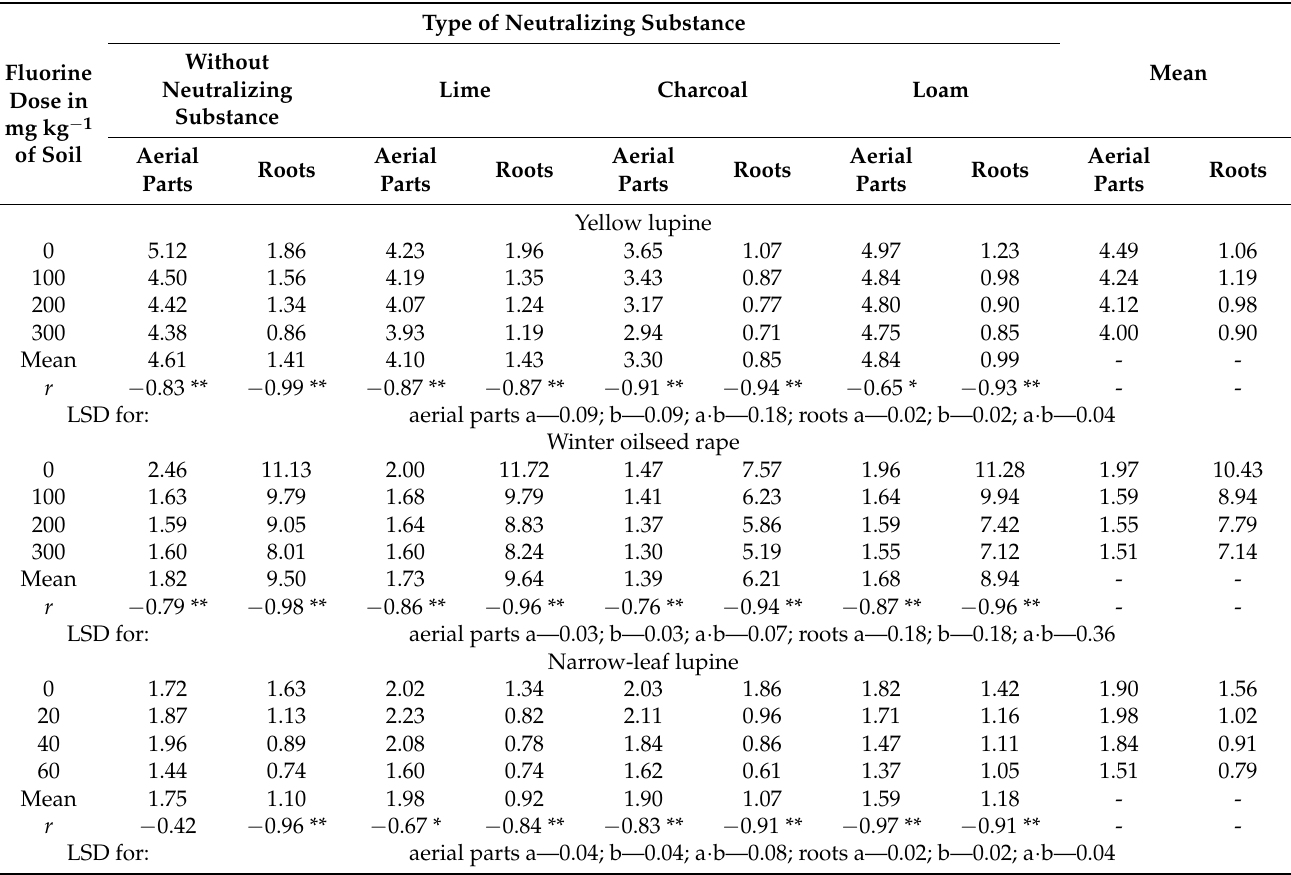
Table 2. Sodium content in yellow lupine, winter oilseed rape, and narrow-leaf lupine in g Na kg − 1